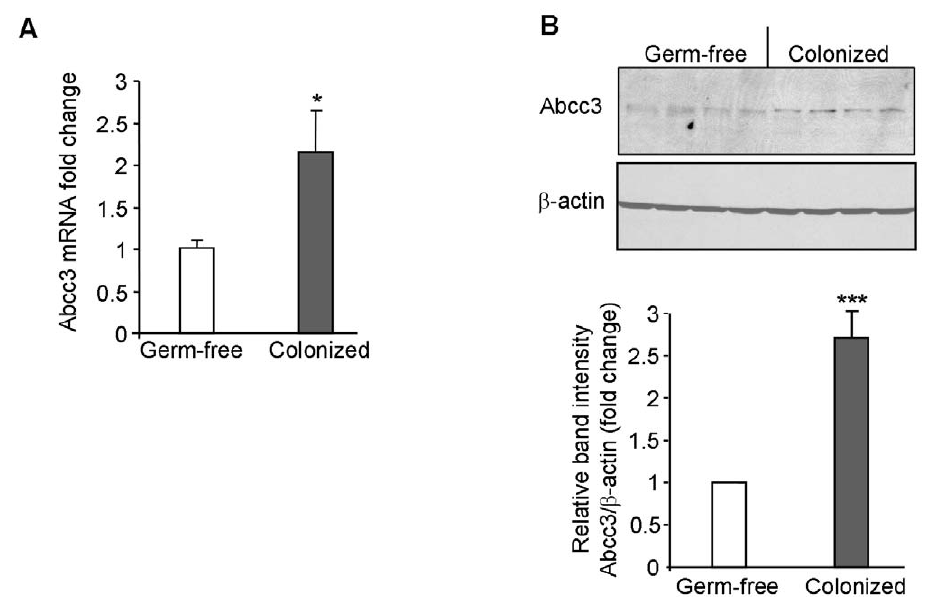
Figure 2. Microbiota up-regulate Abcc3 expression in mouse colon. Germ-free mice were colonized with microbiota from pathogen-free mice. (A) Total RNAs were extracted from the colons of germ-free and colonized mice. Abcc3 mRNA expression levels were assessed by qRT-PCR. Values represent means 6 S.E.M. (n=6/group; * P , 0.05). (B) Abcc3 protein expression levels in the colons of germ-free and colonized mice were assessed by Western blot. Bar graphs in B show the relative intensity of blots (upper panel) with values represent means 6 S.E.M. *** P , 0.01.